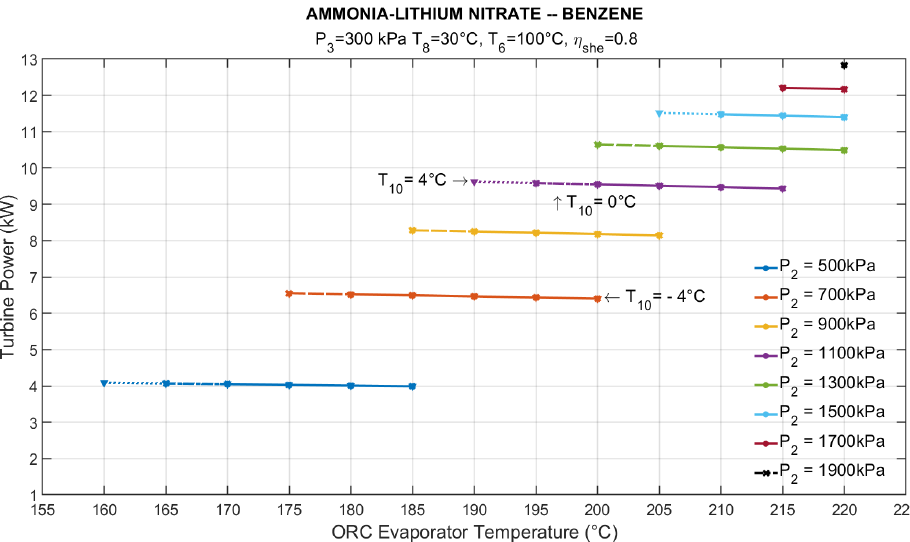
Figure 4. NH 3 -LiNO 3 –C 6 H 6 turbine power as a function of heat source temperature and cooling temperature at di ff erent operating conditions.